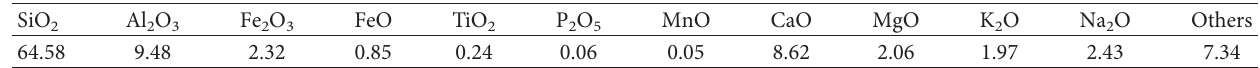
Table 5: Chemical constituents of desert sand.